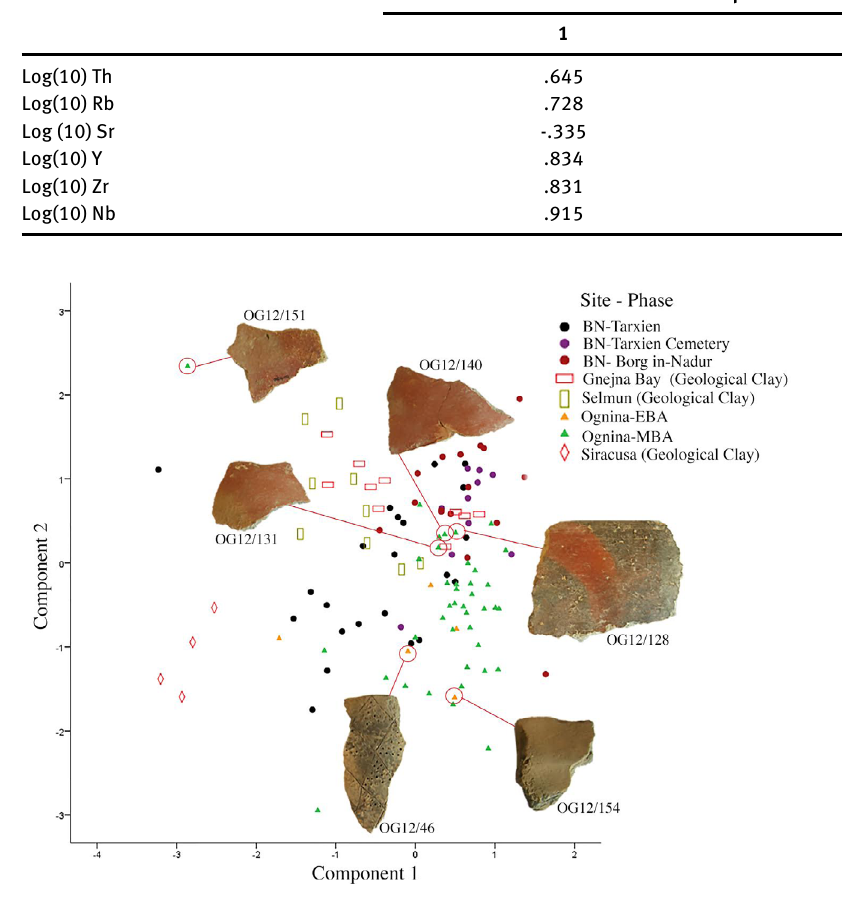
Figure 4. Bivariate scatterplots of principal components scores for all Maltese and Sicilian ceramic and clay samples. The above results were compared to the elemental compositional data for 69 samples, comprising ceramic and clays from Borg in-Nadur (58 samples) and pottery from Ognina (11 samples), analyzed with a Philips X-ray fluorescence spectrometer. The 11 Ognina samples included in this analysis were included also in the analysis conducted with pXRF. The elemental compositions for Zr, Rb, and La showed the greatest variation and were therefore used to create a discriminating triangular diagram (Fig. 5). As with the results obtained using pXRF, the analysis shows that the majority of the Maltese and Sicilian ceramics can be separated into groups based on the clay source used in the production of these wares. Both methods, either where the surfaces of the ceramics were analyzed non-destructively using the Bruker Tracer III-SD or when a powdered sample was taken for each of the ceramic sherds and analyzed by the Philips X-ray fluorescence spectrometer, allow for distinctions to be observed between Maltese and Sicilian ceramics and